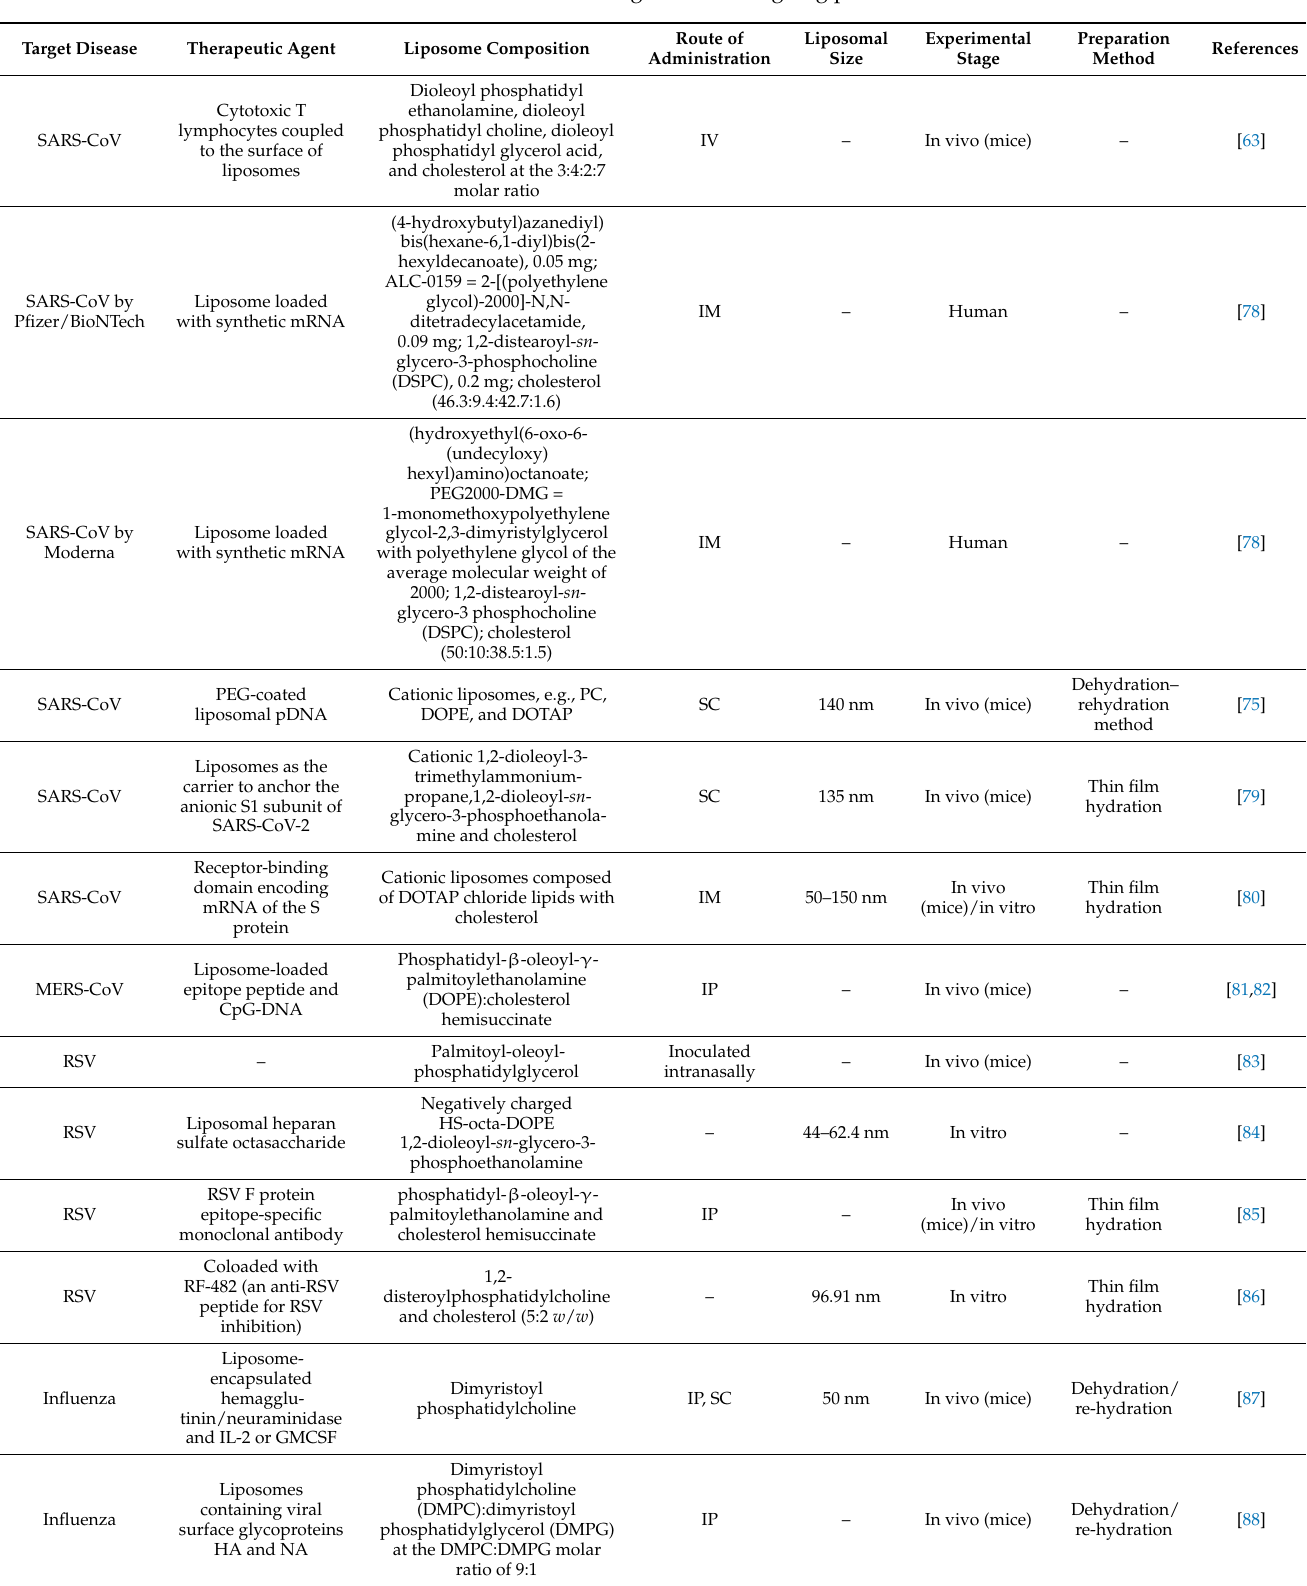
Table 2. Candidate vaccine formulations and stages of their ongoing preclinical and/or clinical